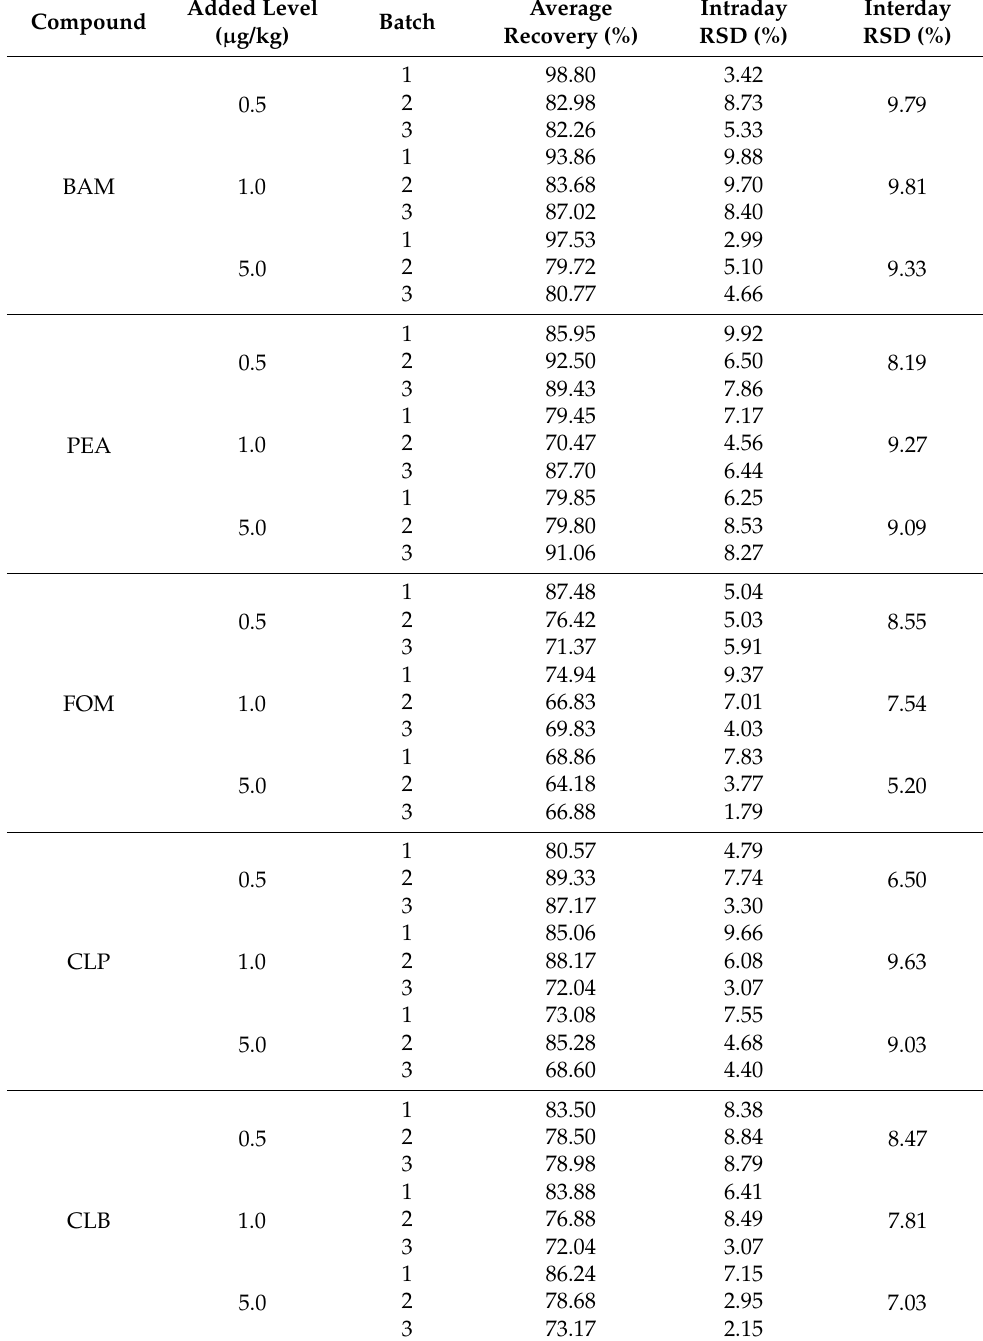
Table A1. Average recovery, intraday precision, and interday precision of the sixteen β -agonists in pork samples (n =